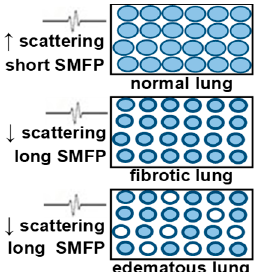
Figure 5. Blue = air-filled alveoli. ( Top ): ultrasound wave into normal lung experiences multiple scatters. Diffusion will be slow ( Middle ): Fibrotic lungs have smaller alveoli, thicker alveolar walls, and more tissue between alveoli, so diffusion will be faster. ( Bottom ): Edematous lung. Some alveoli may be fluid filled (white) which will further increase the distance between scatterers.